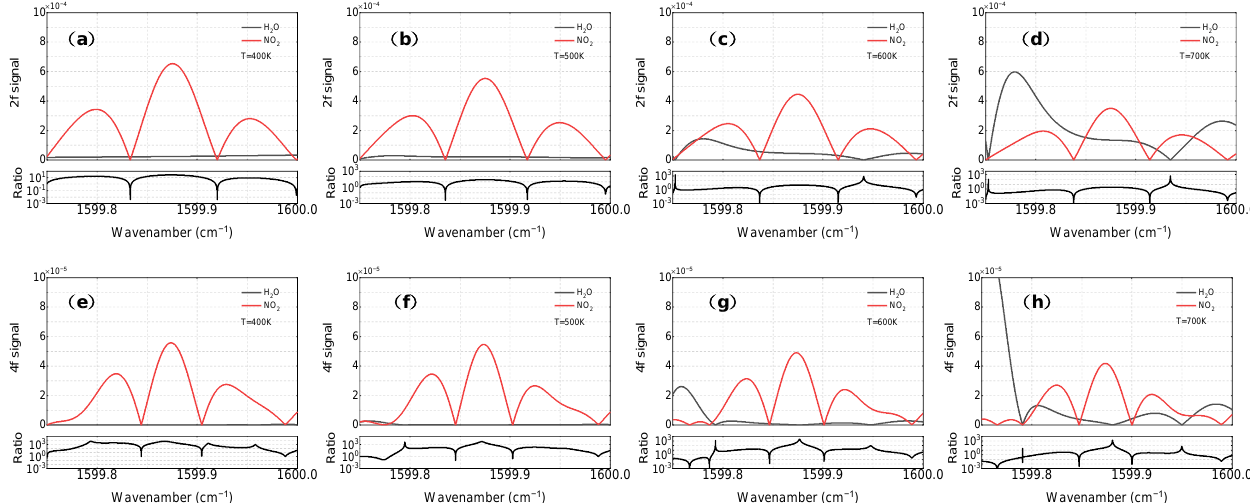
Figure 4. Simulations of 1.5 ppm NO 2 (red) and 15% H 2 O (black) in the typical exhaust temperature range of 400–700 K, P = 1 atm, L = 157.5 cm. The upper line ( a–d ) shows the 2 f line shapes; the lower line ( e–h ) shows the 4 f line shapes.